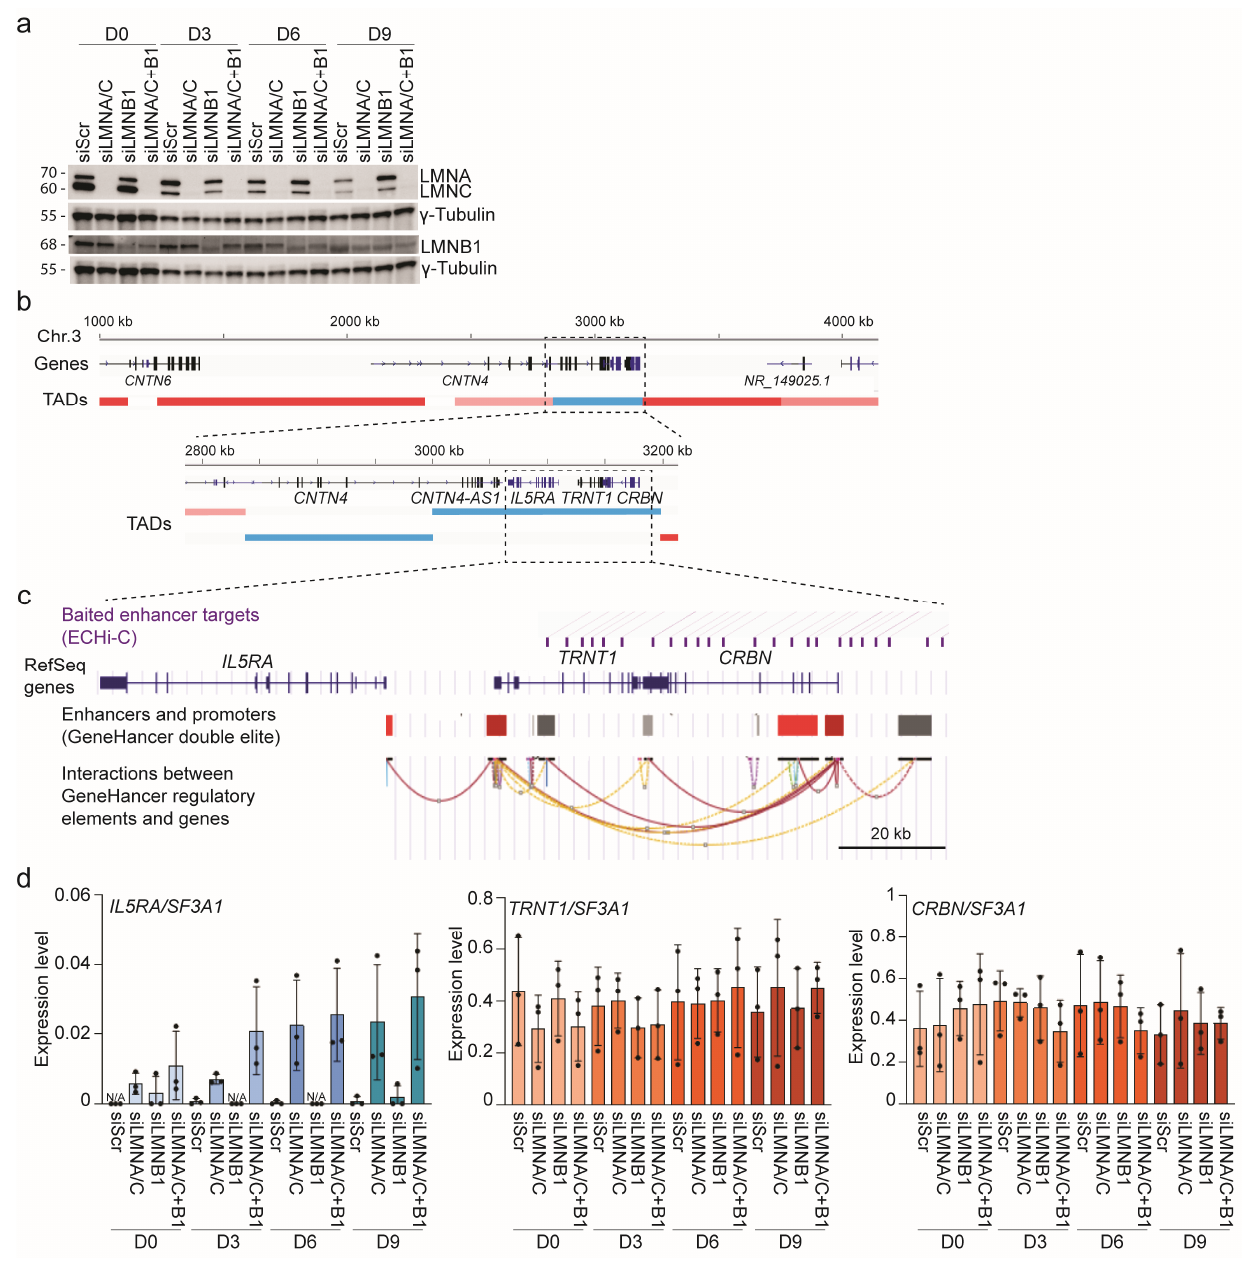
Figure 5. Downregulation of LMNA/C leads to the activation of a silent gene. ( a ) Immunoblotting analysis of LMNA/C and LMNB1 knock ‐ down in ASCs; see also Figure S2. Molecular weights in KDa are shown. ( b ) Genome browser view of TADs in the CNTN4 ‐ CRBN region. The TAD track is from our earlier work and color ‐ coded based on the size of the clique the TADs belonging to [28]: blue, singleton TADs not in clique; pink, TAD in a clique of 4 TADs; red, TAD in a clique of 6 TADs [28]. One bar in the zoom ‐ in view represents one TAD. The zoom ‐ in highlights the IL5RA ‐ TRNT1 ‐ CRBN TAD. ( c ) UCSC genome browser view of enhancer connections in the expressed TRNT1 ‐ CRBN locus in an active cLAD region, along with the repressed flanking IL5RA gene. Enhancer connections are from ECHi ‐ C K4 bait targets (top) and from the GeneHancer double elite enhancer set (https://www.genecards.org; accessed on 19 January 2023) [45]. ( d ) RT ‐ qPCR analysis of IL5RA , TRNT1 and CRBN after knock ‐ down of LMNA/C, LMNB1 or both, and in scrambled siRNA control (siScr) cells at indicated differentiation time ‐ points; mean ± SD of 3 experiments; individual values are shown. Expression of CNTN4 was undetected in each experiment (not shown).